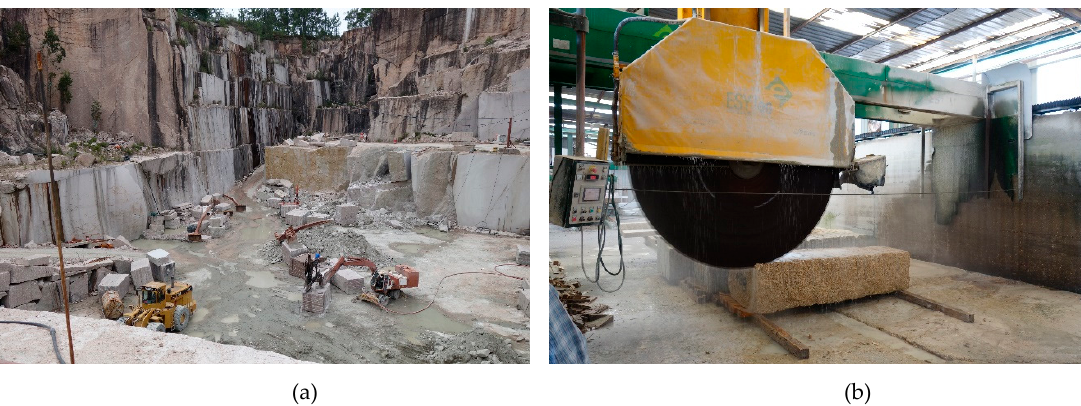
Figure 1. Granite powder waste production . ( a ) Granite quarry; ( b ) process of cutting granite blocks.